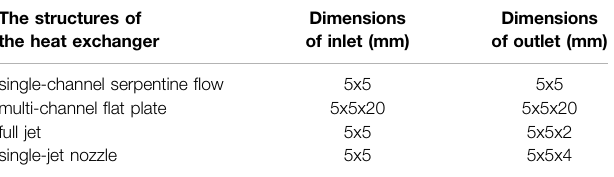
TABLE 1 | Speci fi c parameters of the simulated heat exchanger. The structures of the heat exchanger